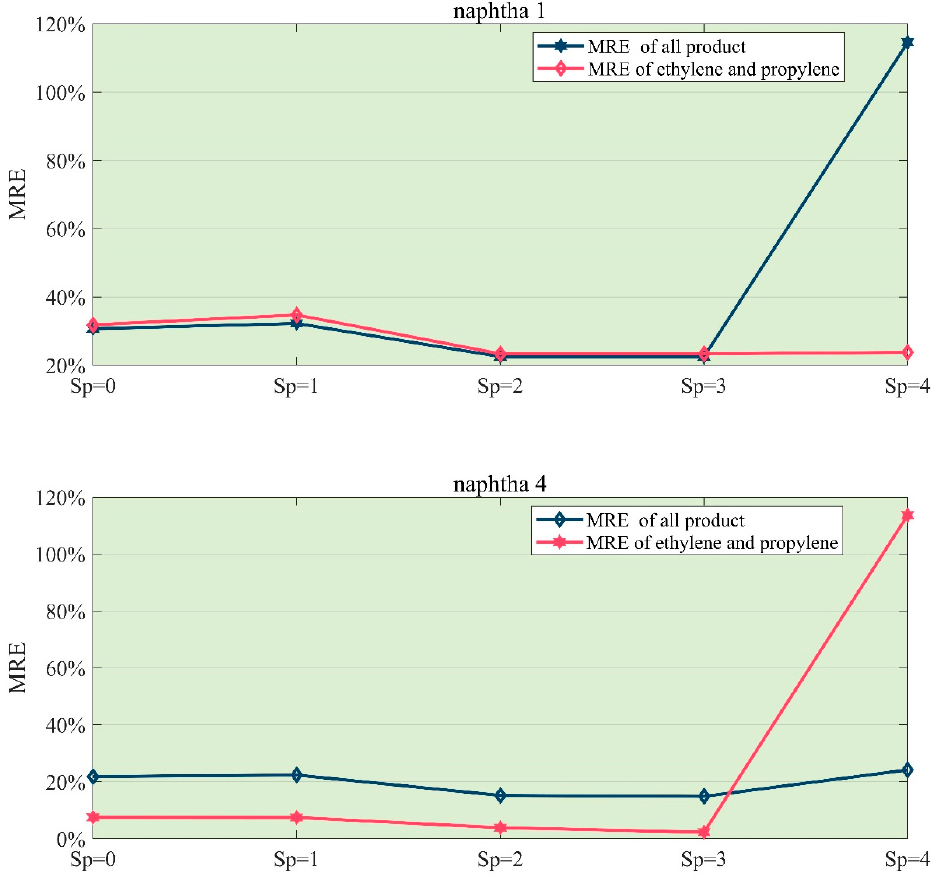
Figure 7. MRE of the K-R model in conditions of different Sp. Table 9. Compared Result between the Kumar and K-R models with naphtha (1).